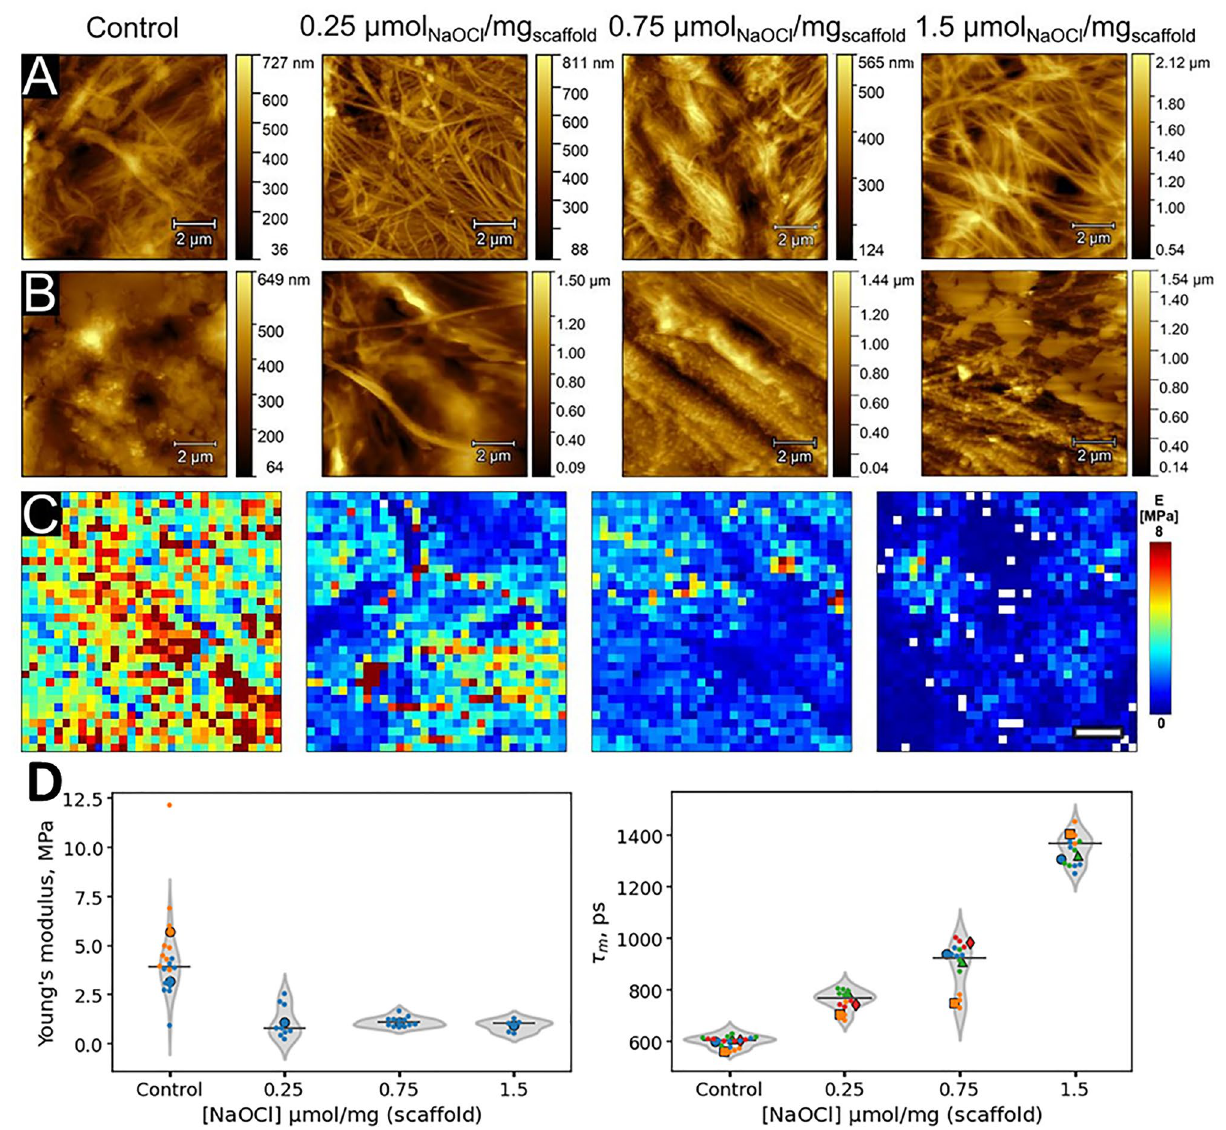
Figure 4. Representative AFM data obtained on the decellularized bovine pericardium scaffolds cross-linked with genipin (DBP-G) treated with sodium hypochlorite. ( A – B ) Topography images of the control DPB-G scaffold and DPB-G scaffolds, treated with 0.25, 0.75, 1.5 µmol (NaOCl)/mg (scaffold): fibrillar areas ( A ) and amorphous areas ( B ). ( C ) Nanomechanical maps (distribution of Young’s modulus, E ) of the control and treated DBP-G samples. All images have the same color-coded scale for the modulus; the scale bar is 2 µm. ( D ) Young’s modulus of the control DPB-G sample and DBP-G samples treated with 0.25, 0.75 and 1.5 µmol (NaOCl)/mg (scaffold) (left panel), and increase in the fluorescence lifetime τ m for the same samples (right panel). Data in panel ( D ) is represented in the form of superplot: small dots represent the average Young’s modulus and the fluorescence lifetime τ m averaged over the one image, while large dots represent the average over the replicated experiments. Horizontal lines represent the total average obtained for treated and untreated DBP-G